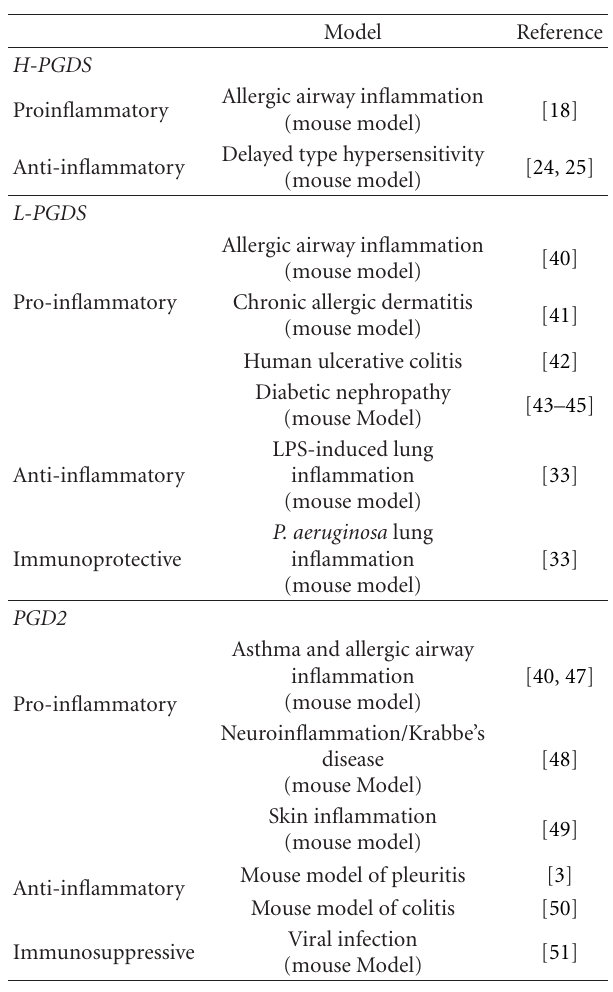
Table 1: Summary of PGDS and PGD 2 e ff ects in models of inflam-